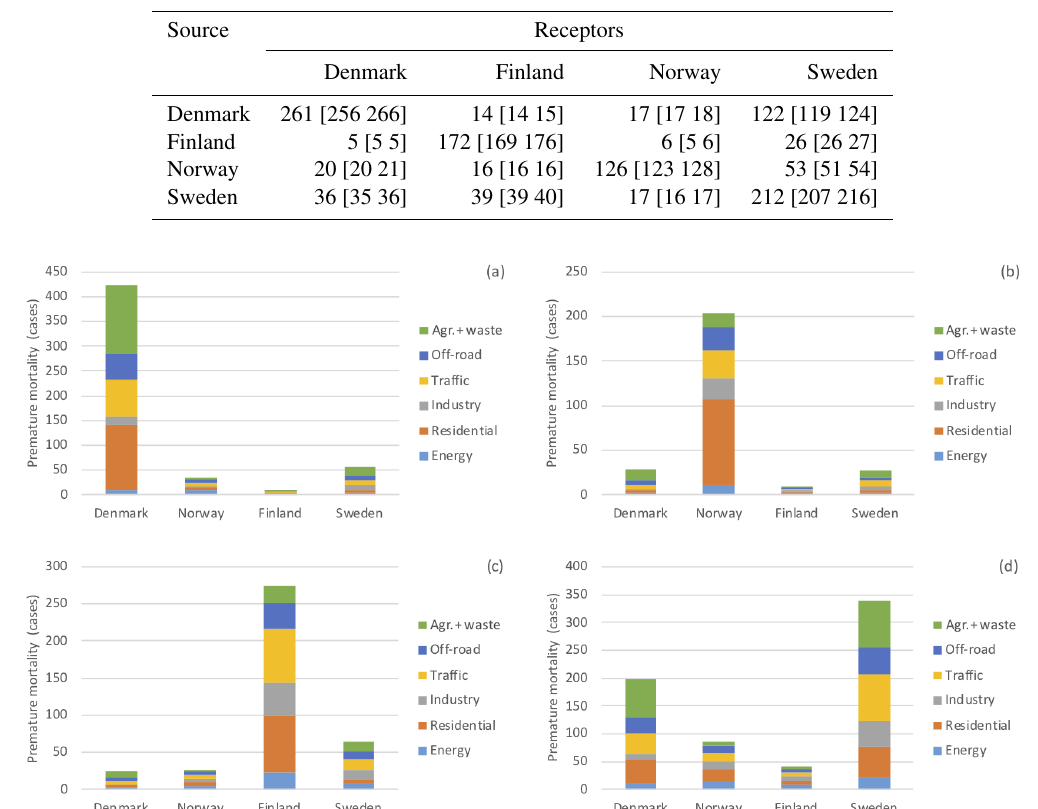
Figure 13. Source contributions from the anthropogenic emissions of (a) Denmark, (b) Norway, (c) Finland and (d) Sweden to total premature mortality (acute plus chronic) in the Nordic